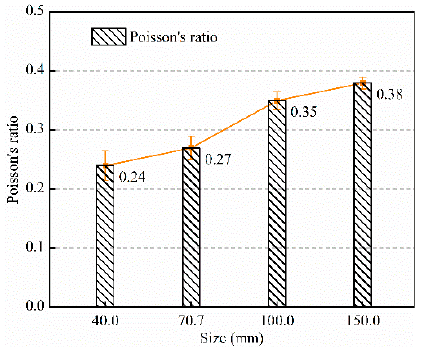
Figure 12. Poisson’s ratio of backfills with different sizes.